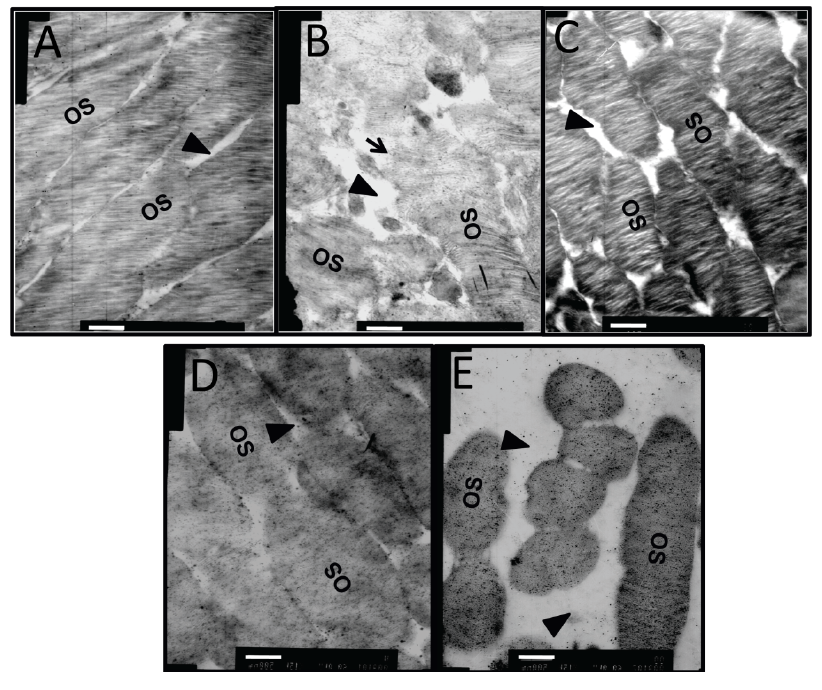
Figure 8. The ultrastructural changes in the retinal photoreceptor outer segment of diabetic rats after dual-target intervention. Representative TEM images of retinal photoreceptor outer segments in normal controls ( A ); diabetic rats without intervention ( B ); diabetic rats with dual intervention ( C ); and diabetic animals with ranibizumab ( D ) or CTGF shRNA single intervention ( E ) are shown ( n = 5). Black triangles designate the gap between outer segments, black arrow shows the dissolved membrane discs. OS: outer segment. Scale bar = 500